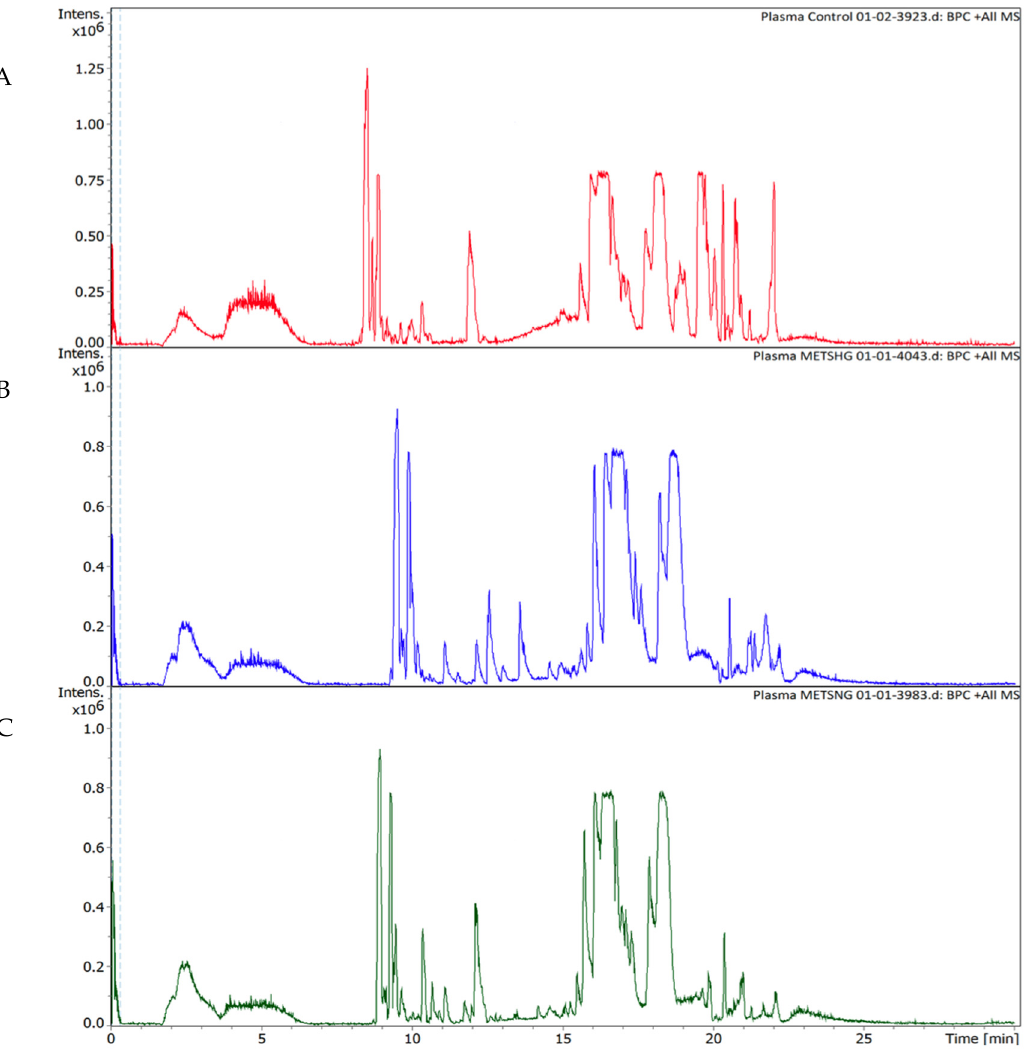
Figure 6. Positive ion base peak intensity chromatograms obtained from the analysis of ( A ) the control group, ( B ) the prediabetic MetS group, and ( C ) the normoglycemic MetS group.